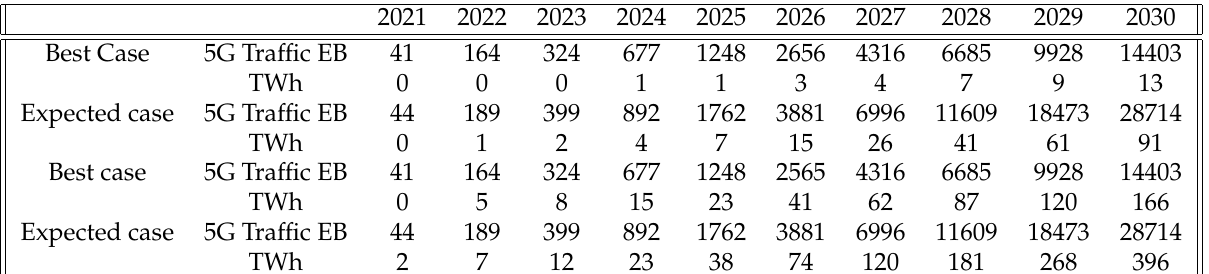
Table 2. Differences between [3] and the present prediction for 5G mobile networks.